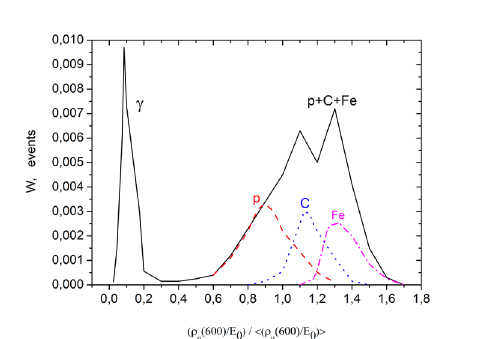
Figure 1. Distribution of showers with energies above 10 18 eV and zenith angle θ 70 ◦ . The curves are gamma ray γ (solid), ≤ proton p (dash), carbon C (dot) and iron nucleus Fe (dash-dot) as simulated with QGSjetII-04 [6,